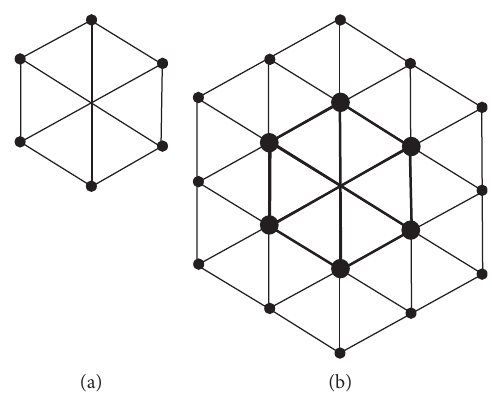
Figure 2: Hexagonal meshes: (a) HX (2) and (b) HX (3).